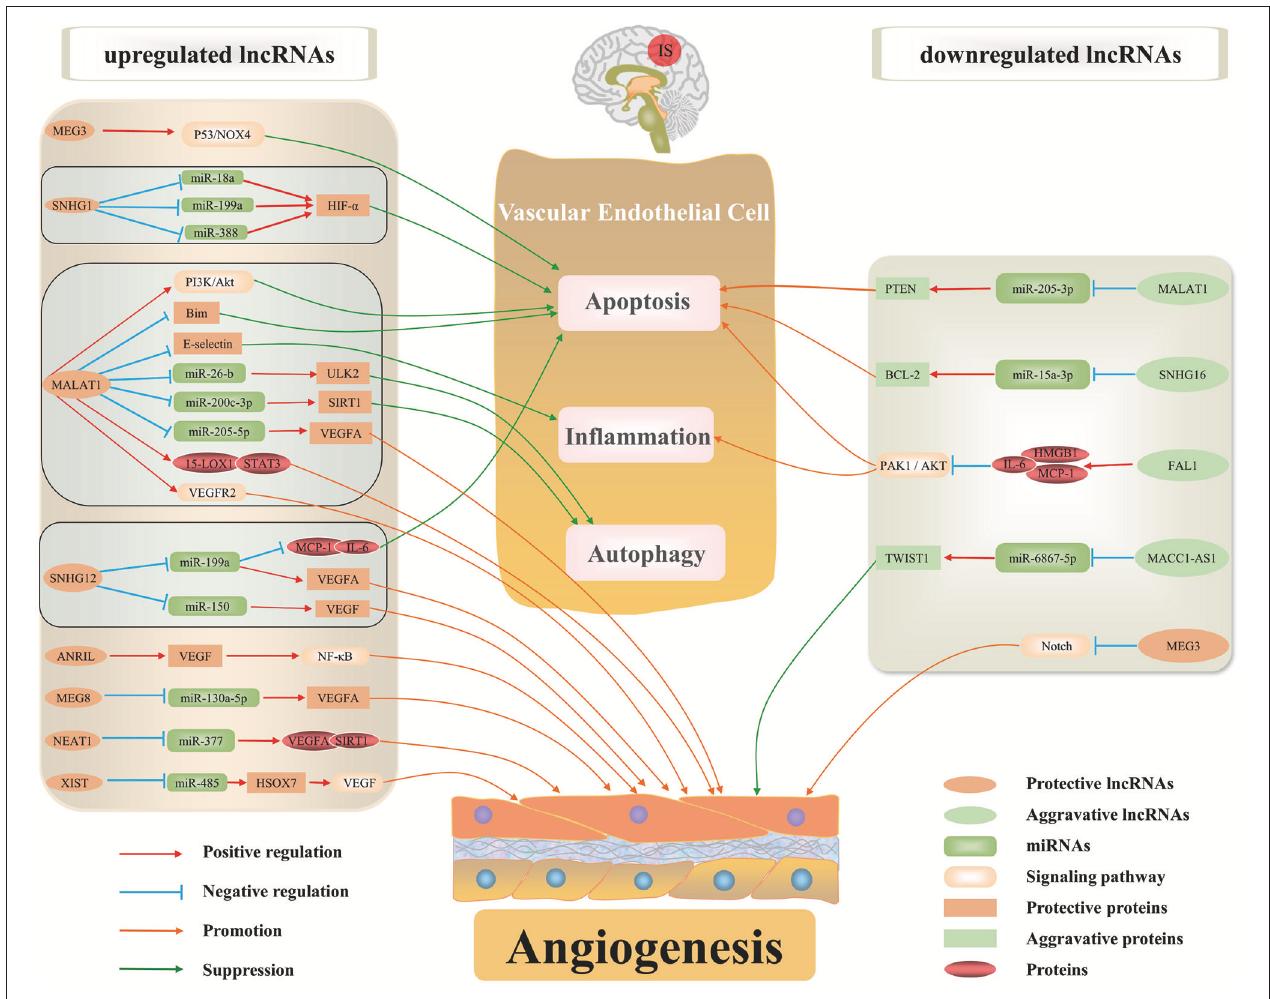
FIGURE 1 | The regulatory mechanisms of lncRNAs in ischemic stroke-induced angiogenesis. Some lncRNAs serve essential roles on angiogenesis after ischemic stroke by regulating inflammation, autophagy and apoptosis of BMECs, or directly regulating angiogenesis-associated proteins/signaling pathways to maintain vascular function and integrity. Certain lncRNA may regulate the expression of multiple target genes in various pathways involved in